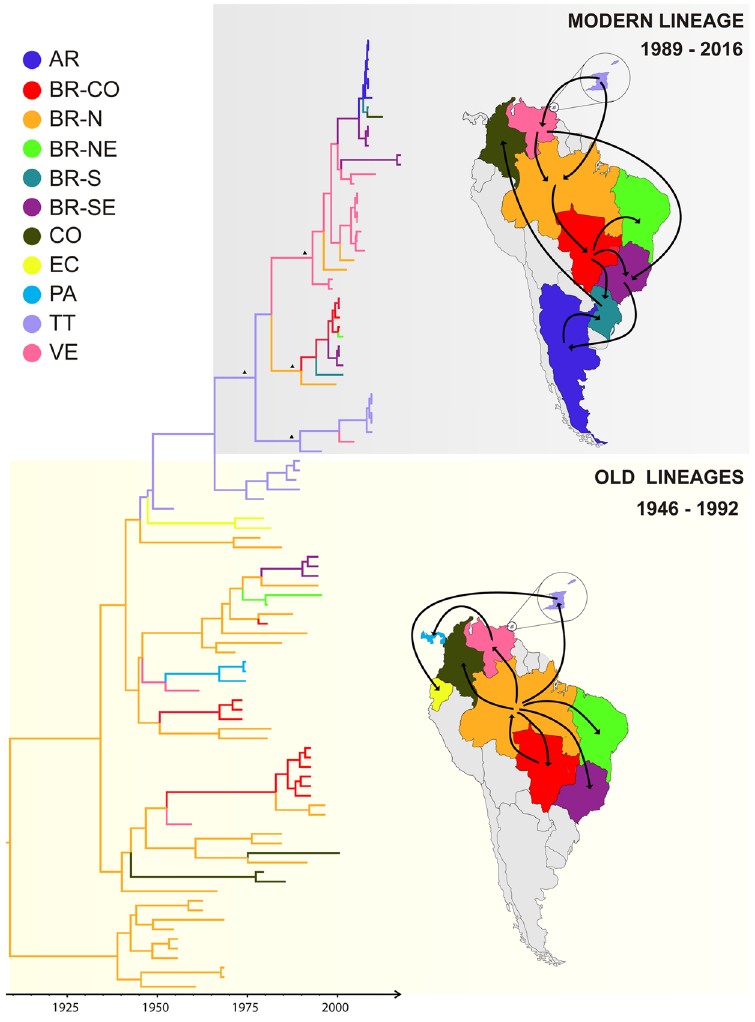
Figure 1. Time-scaled Bayesian phylogeographic MCC tree of the YFV genotype I prM/E gene sequences. Branches are colored according to the most probable location state of their descendent nodes as indicated at the legend (top left). Key ancestral nodes of modern-lineage subclades with high posterior probability support (clade credibility > 0.99) are indicated with dark full triangles. All horizontal branch lengths are drawn to a scale of years. The tree is automatically rooted under the assumption of a relaxed molecular clock. (AR: Argentina, BR-CO: Brazil Central-West, BR-N: Brazil North, BR-NE: Brazil Northeast, BR-S: Brazil South, BR-SE: Brazil Southeast, CO: Colombia, EC: Ecuador, PA: Panama, TT: Trinidad and Tobago, VE: Venezuela). Viral migration events occurred within the old lineages (1946–1992) and the modern one (1989–2016) are summarized in the maps. Lines between locations represent branches in the Bayesian MCC tree along which location’s transitions occur. Maps were created with CorelDraw from templates obtained from d-maps.com. (South America: http:// www.d-maps.com/carte.php?num_car = 28522&lang = en; and Brazil: http://www.d-maps.com/carte.php?num_ car = 16016&lang =